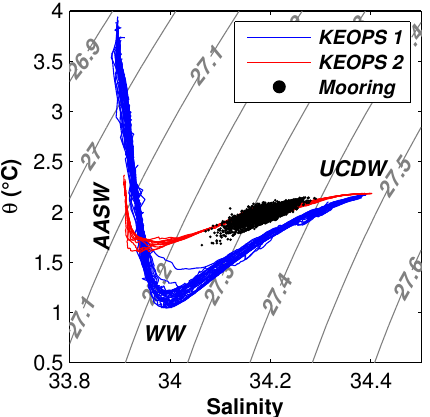
Figure 4. Potential temperature–salinity diagram at station A3. Data are from the moored CTD (black dots), KEOPS1 (blue line) and KEOPS2 (red line). Grey lines are potential density anomaly. The different water masses are Antarctic Surface Water (AASW), Winter Water (WW) and Upper Circumpolar Deep Water